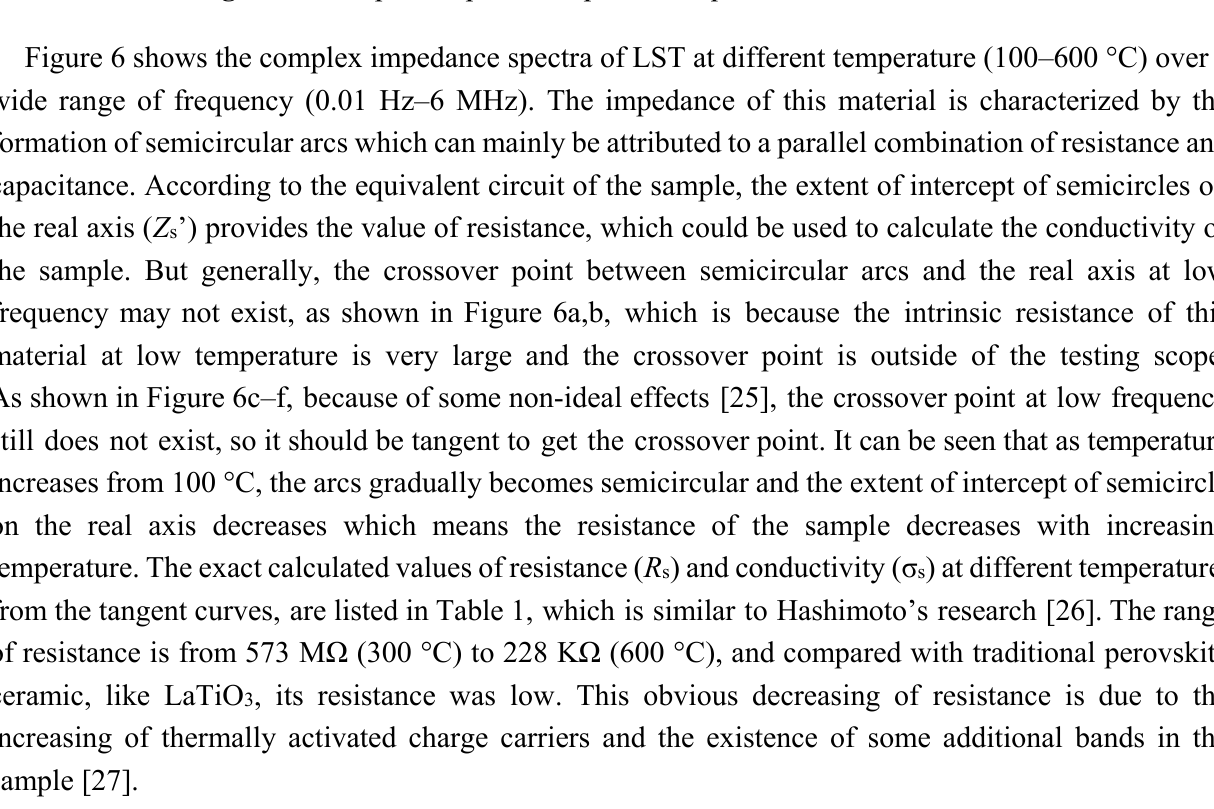
Figure 5. Complex impedance spectrum equivalent electrical circuit.